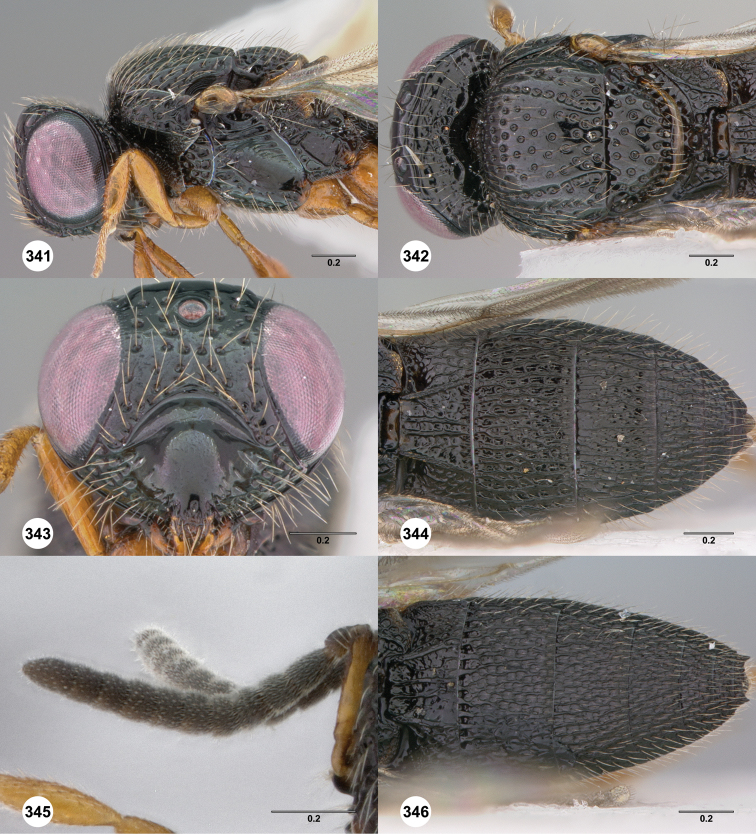
Oxyscelio sordes sp. n., paratype female (OSUC 439664) 341 Head and mesosoma, lateral view 342 Head and mesosoma, dorsal view 343 Head, anterior view 344 Metasoma, dorsal view. Paratype male (OSUC 439677) 345 Antenna 346 Metasoma, dorsal view. Morphbank92